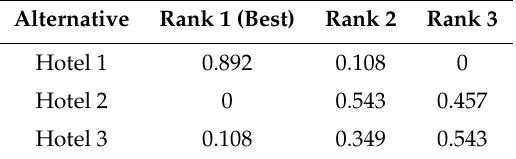
Table 6. Rank acceptability indices: probability of attaining each ranking position. Alternative